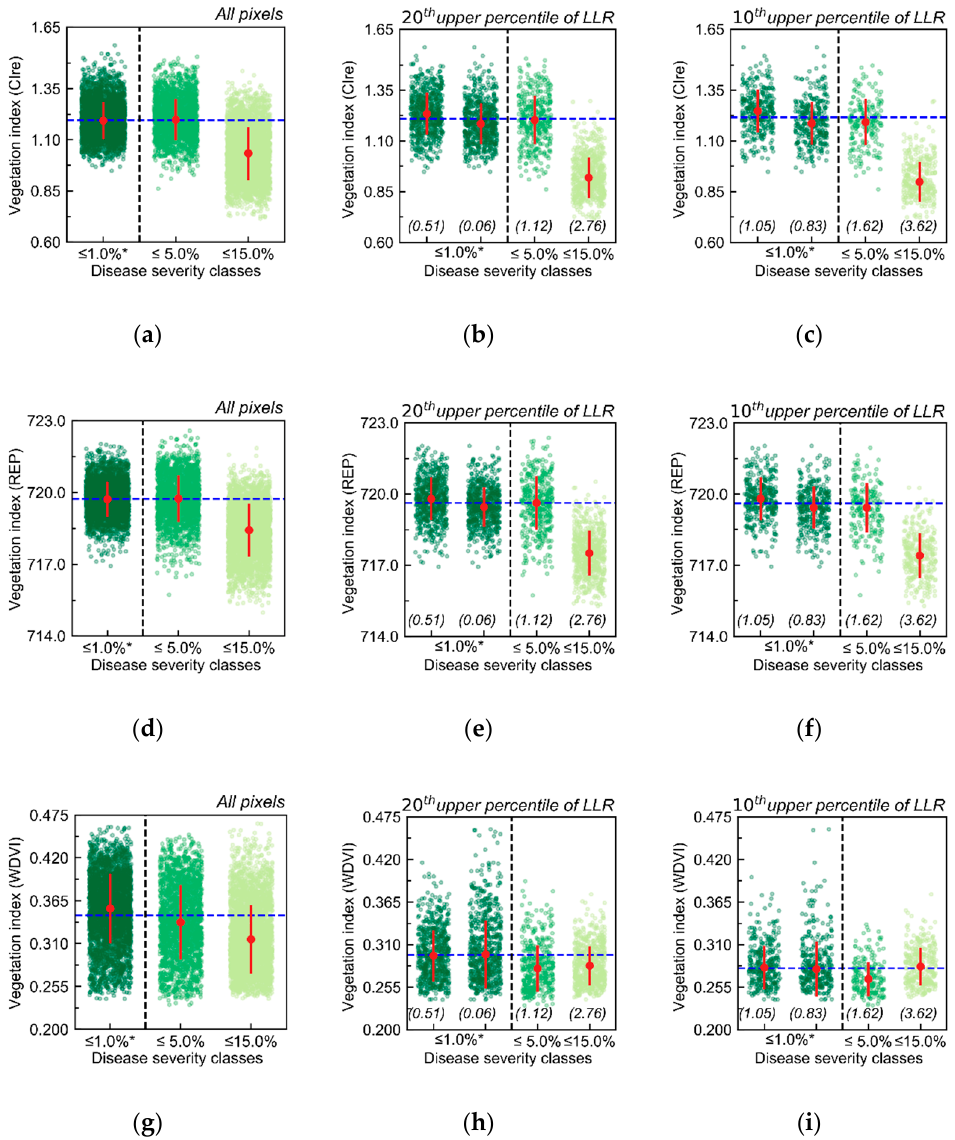
Figure 8. Distribution of vegetation indices (VIs; CIre ( a – c ); REP ( d – f ); WDVI ( g – i )) values for sampling units within different disease severity (DS) classes. Only selected VIs providing relatively good discriminative potential between healthier references, and the DS classes considered (Table A8) for UAV imagery acquire 78 DAP are presented. Green dots indicate pixels within a given DS class (from ≤ 1.0% up to between 10.0% and 15.0%), while red dots and red error bars correspond to median and standard deviation for these observations. Values in parentheses indicate the log-likelihood ratio (LLR) threshold used to selected pixels in a given percentile. Black dashed lines separate healthier observations (references—*) from other DS classes. Blue dashed lines indicate the average VI value for pixels included in the references. It is worth noting that for the percentiles, two distinct sets of pixels represent the reference, one for each DS class above 1.0%